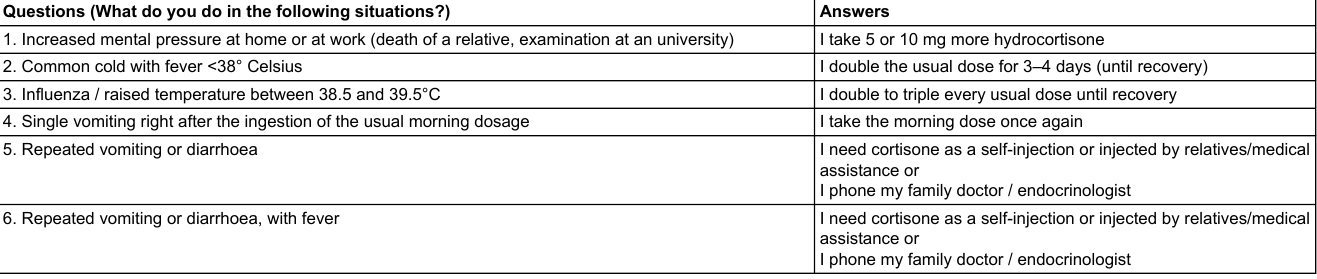
Table 2: Questions part B, assessing the knowledge about dose adaptation in different hypothetical situations. Questions (What do you do in the following